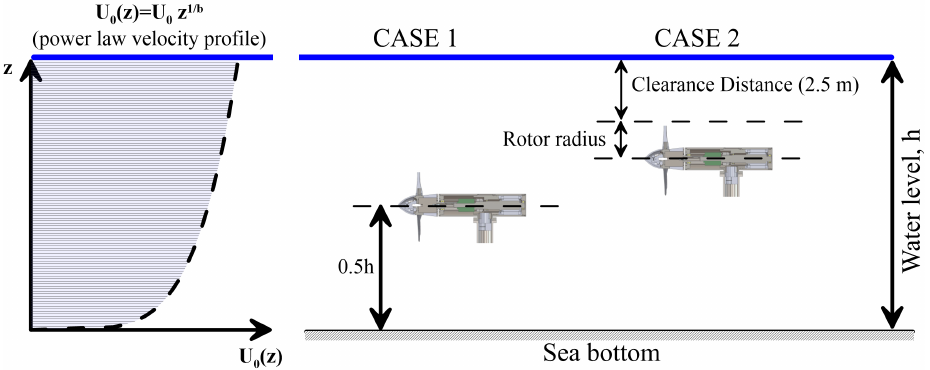
Figure 2. Case studies for BEM simulations considering the hub location within the water column as well as the development of velocity profiles based on power law fitting curve based on ADCP